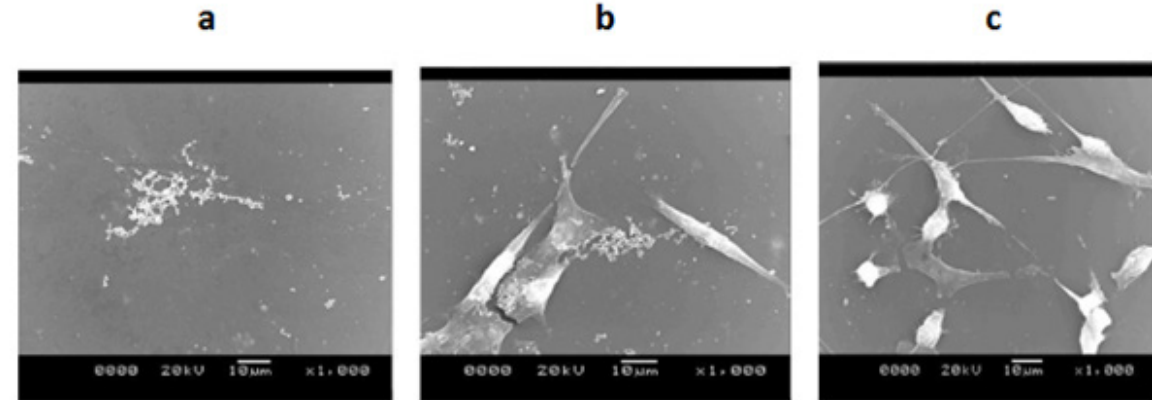
Figure 5 - SEM micrographs of a ) mPE, b ) mPE-2.5 J/cm 2 and c ) mPE-5 J/cm 2 treated samples seeded with 3T3 fibroblast cells. A representative image of three individual experiments is